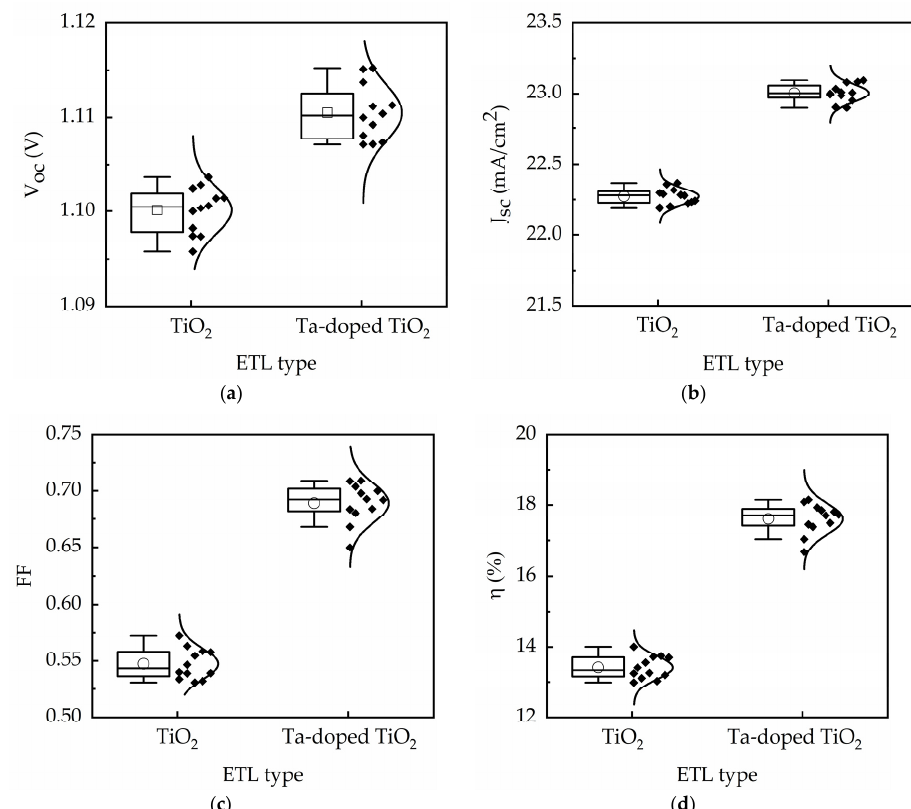
Figure 9. Performance of 12 devices for TiO 2 and Ta-doped TiO 2 perovskite solar cells: ( a ) V oc , ( b ) J sc , ( c ) FF, and ( d ) η